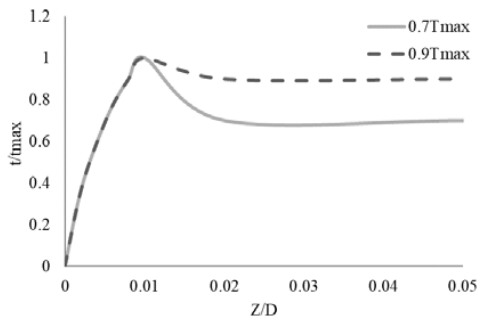
Figure 3. Typical axial pile load transfer–displacement (T–Z) curve for cohesive soil.